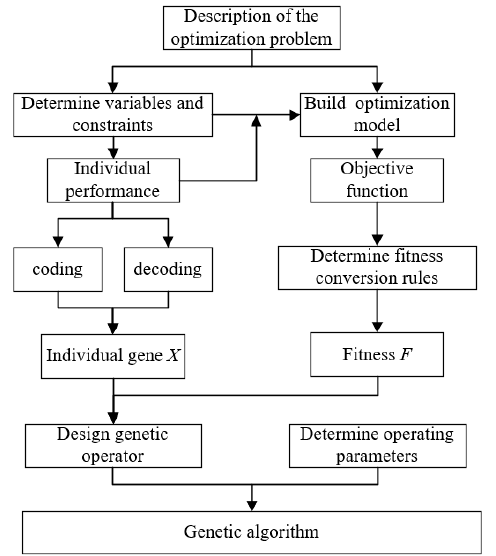
Figure 2. Genetic algorithm for the optimal solution process.